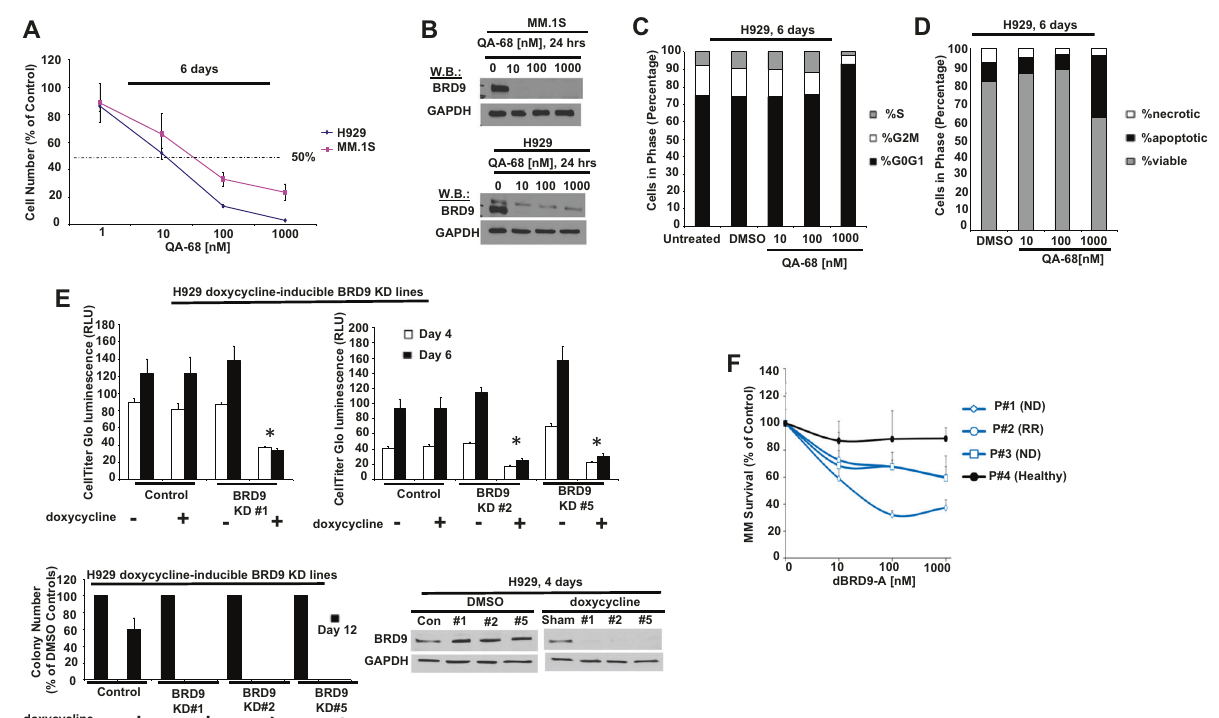
Fig. 6 Targeted loss of BRD9 protein in MM leads to inhibition of cell proliferation, cell cycle progression, and colony formation and a decrease in viability. A Proliferation assays: MM.1S or H929 cells treated with QA-68. 6-day assay. B Effects of QA-68 on BRD9 expression in MM.1S and H929 cells. 24-hour assay. C Effects of QA-68 on H929 cell cycle progression. 6-day assay. D Effects of QA-68 on H929 apoptosis. 6-day assay. E , upper panels Proliferation of H929 control cells and doxycycline-inducible BRD9 KD H929 cells + /-doxycycline. 4- and 6-day assays. Asterisks indicate statistical signi fi cance. E , upper left panel: t-test, 4-day: H929 control (-dox): H929 control ( + dox) ( P = 0.1761); H929 BRD9 KD#1 (-dox): H929 BRD9 KD#1 ( + dox) ( P < 0.0001). E , upper right panel: t-test, 4-day: H929 control (-dox):H929 control ( + dox) ( P = 0.2475); H929 BRD9 KD#2 (-dox):H929 BRD9 KD#2 ( + dox) ( P < 0.0001); H929 BRD9 KD#5 (-dox):H929 BRD9 KD#5 ( + dox) ( P < 0.0001). E , upper left panel: t-test, 6-day: H929 control (-dox):H929 control ( + dox) ( P = 0.9899); H929 BRD9 KD#1 (-dox):H929 BRD9 KD#1 ( + dox) ( P = 0.0004). E , upper right panel: t-test, 6-day: H929 control (-dox):H929 control ( + dox) ( P = 0.9316); H929 BRD9 KD#2 (-dox):H929 BRD9 KD#2 ( + dox) ( P < 0.0001); H929 BRD9 KD#5 (-dox): H929 BRD9 KD#5 ( + dox) ( P < 0.0003). E , lower left panel Effects of doxycycline-inducible BRD9 KD on H929 colony formation. 1000 cells/mL/well were seeded; colonies were counted 12 days postseeding. Colonies were counted twice/well. Data are presented as percent of DMSO-treated (-doxycycline) control wells. E , lower right panel BRD9 expression in H929 control cells and doxycycline-inducible BRD9 KD H929 cells + /- doxycycline. DOX, 1 µg/ml; DMSO, 0.1%. F Effects of BRD9 degrader treatment on proliferation of three primary MM patient samples versus one normal/healthy bone marrow sample, cultured in 3D tissue engineered bone marrow (3DTEBM). 5-day assay. MM bone marrow aspirates were treated with dBRD9-A (concentration range 10 – 1000 nM; compounds added inside 3D and outside 3D); MM survival was tested by fl ow cytometry (cell number normalized to counting beads, and then normalized to control). ND Newly Diagnosed, RR